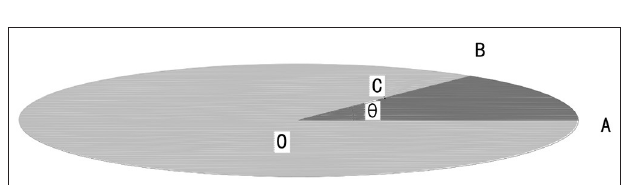
FIGURE 2 | Location of the fracture center, C. The azimuthal angle θ as well as the radius OB could be defined according to the random black area swept out by a radius of this ellipse. Point C is chosen along OB using a normalized function (Equations 3, 4).